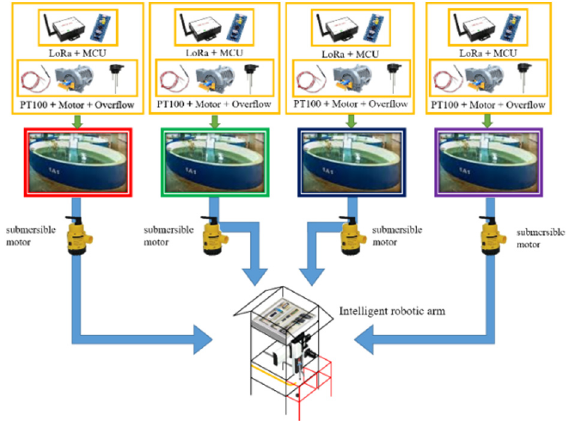
Figure 2. System architecture.